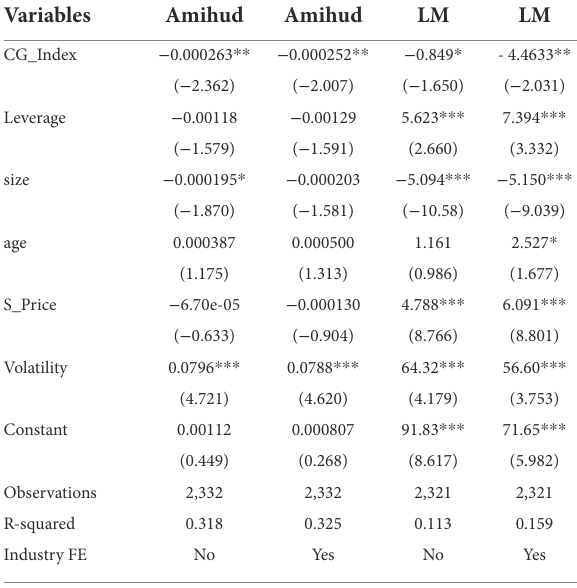
TABLE 11 Corporate governance index and stock liquidity (OLS Regression).